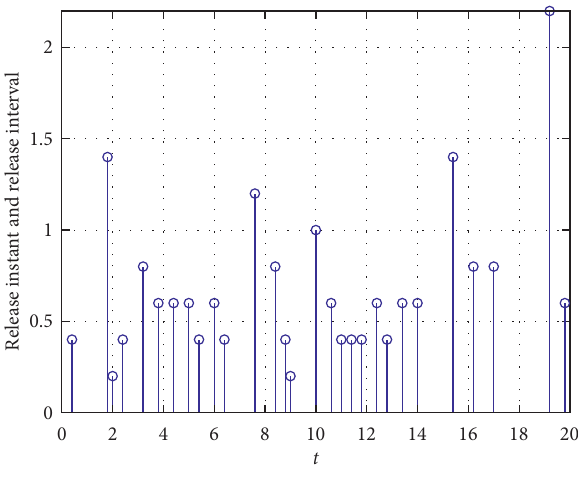
Figure 5: Release instants and release intervals.